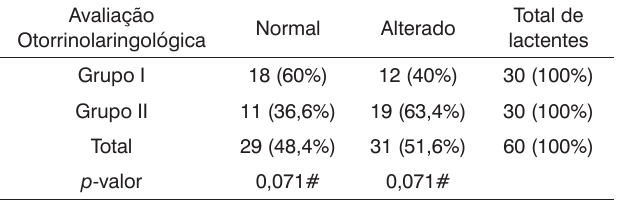
Tabela 1. Resultados da avaliação otorrinolaringológica nos